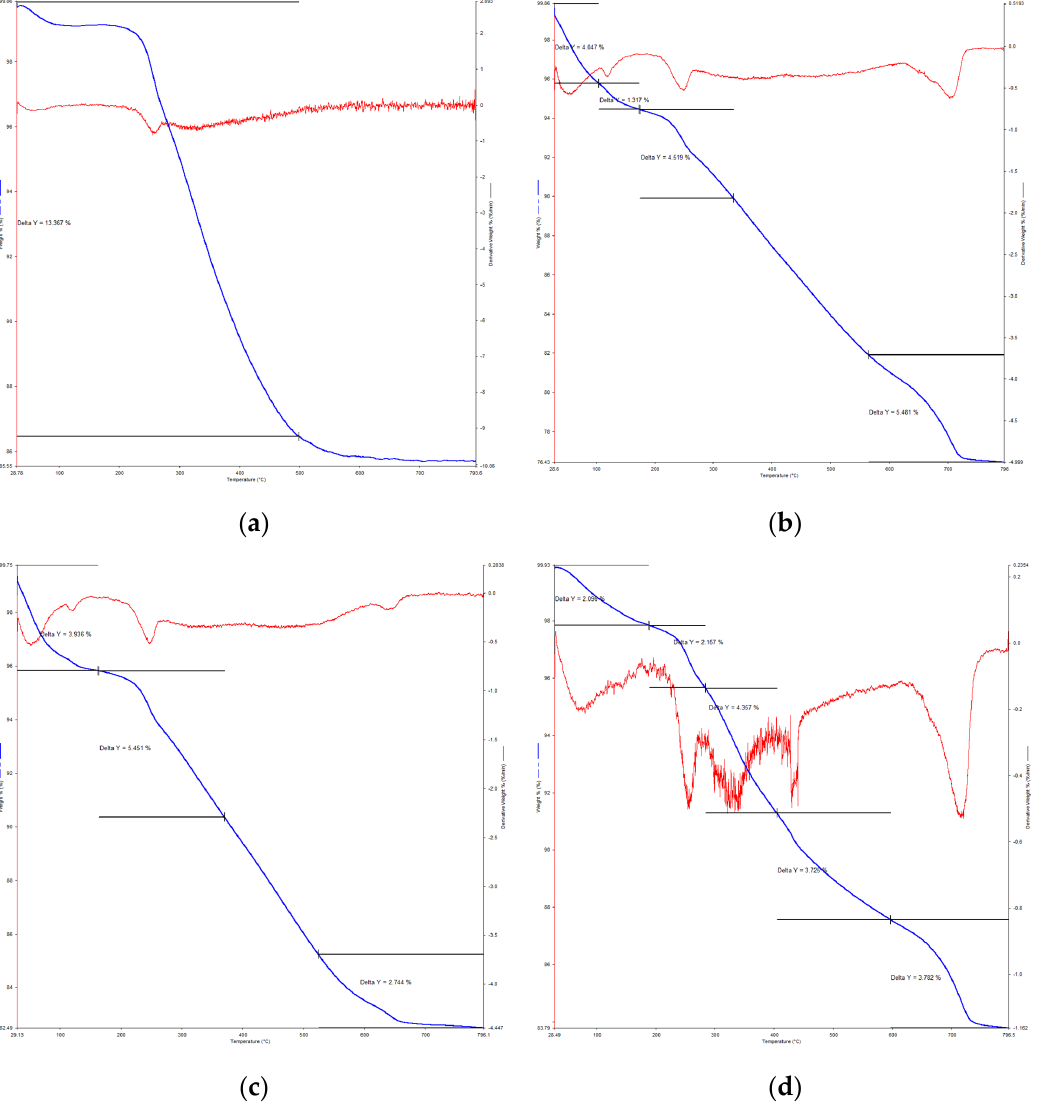
Figure 8. Thermogravimetric analysis of treated and untreated peat. ( a ) Peat, ( b ) Peat + OPC, ( c ) Peat + SF, and ( d ) Peat + OPC +